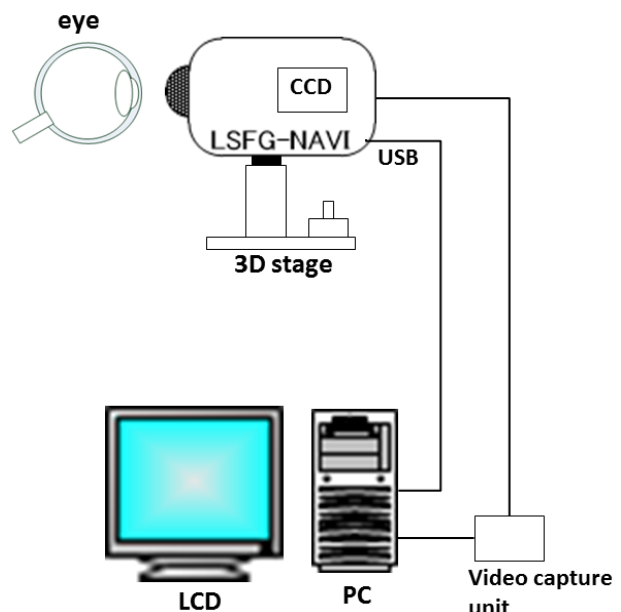
Figure 2. Block diagram of the LSFG-NAVI system. USB: universal serial bus, PC: personal computer, LCD: liquid crystal display.